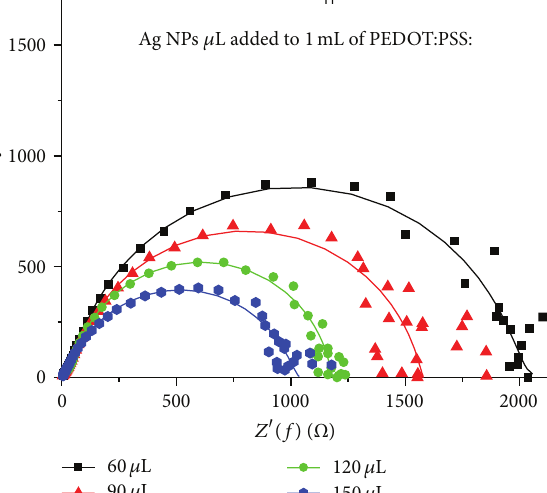
Figure 6: Current density-voltage characteristics of all investigated devices with Ag NPs ( J-V measurement immediately after construc- tion and after 8 months). Figure 7: Impedance spectra of ITO/PEDOT:PSS:Ag NPs/P3HT: